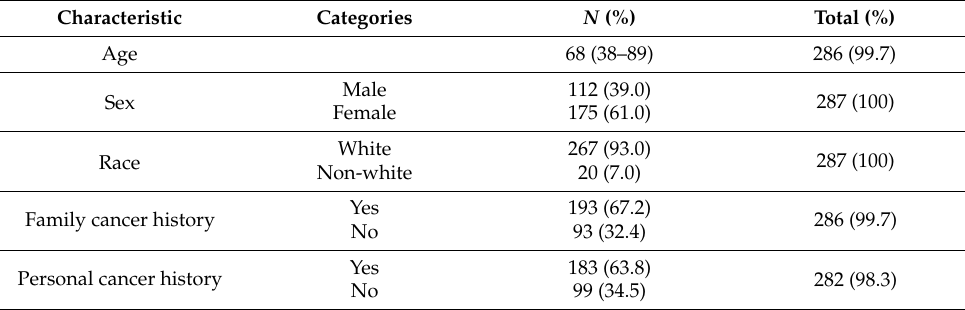
Table 1. Baseline characteristics of the patients in Cohort 1